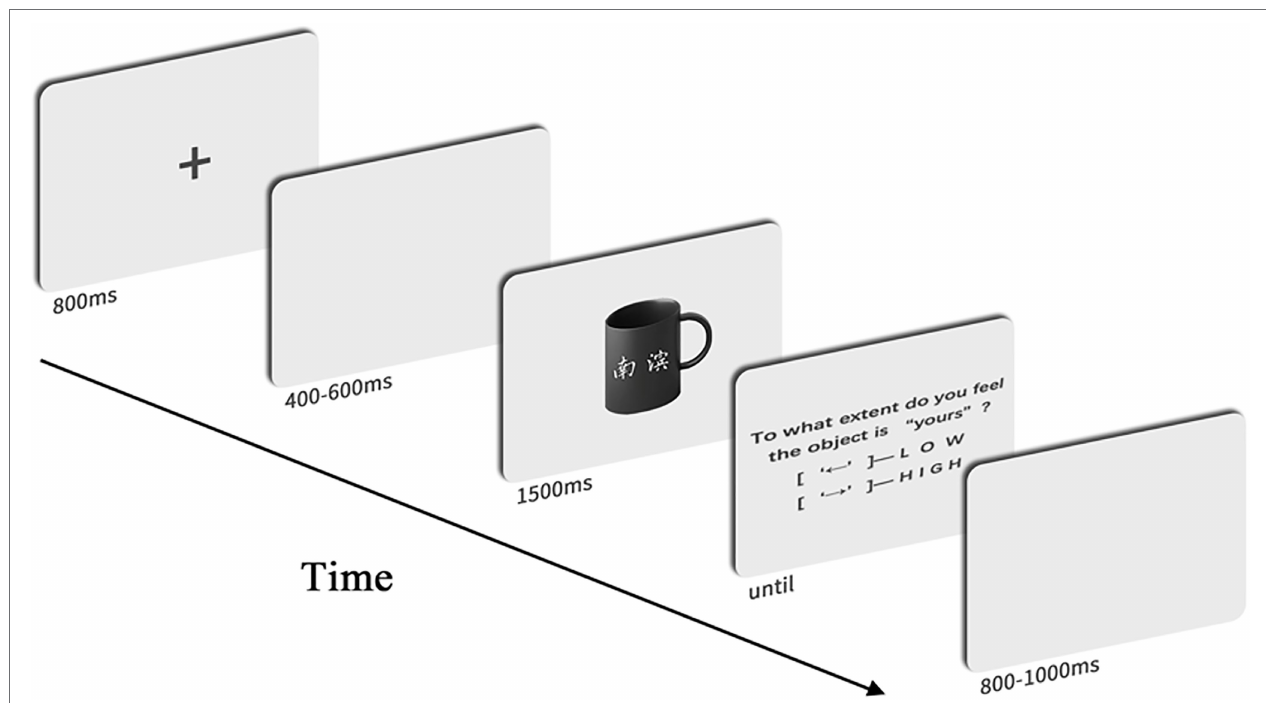
FIGURE 3 | Time course of a single trial. Each trial began with an 800-ms fixation point followed by blank screen, which were randomized between 400 and 600 ms. A screen displaying the object was shown for 1,500 ms. Then, a question screen appeared until the participants responded. The inter-trial interval was randomized to last between 800 and 1,000